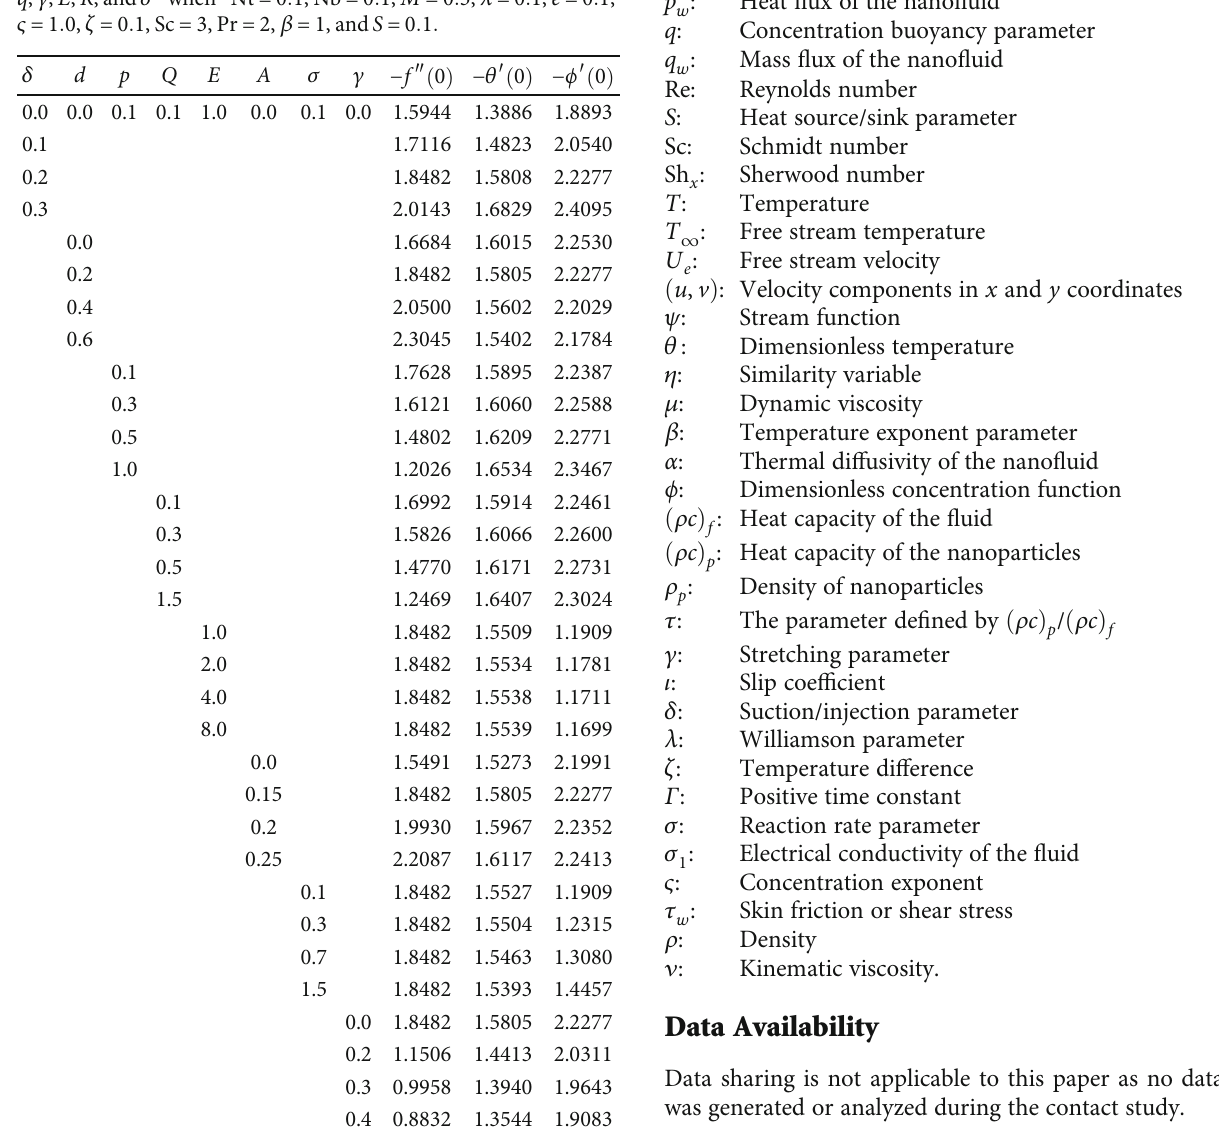
Table 3: Numerical results of the skin friction coe ffi cient, Nusselt number, and Sherwood number for di ff erent values of δ , d , p , q , γ , E , R , and σ when Nt = 0 : 1, Nb = 0 : 1, M = 0 : 3, λ = 0 : 1, e = 0 :